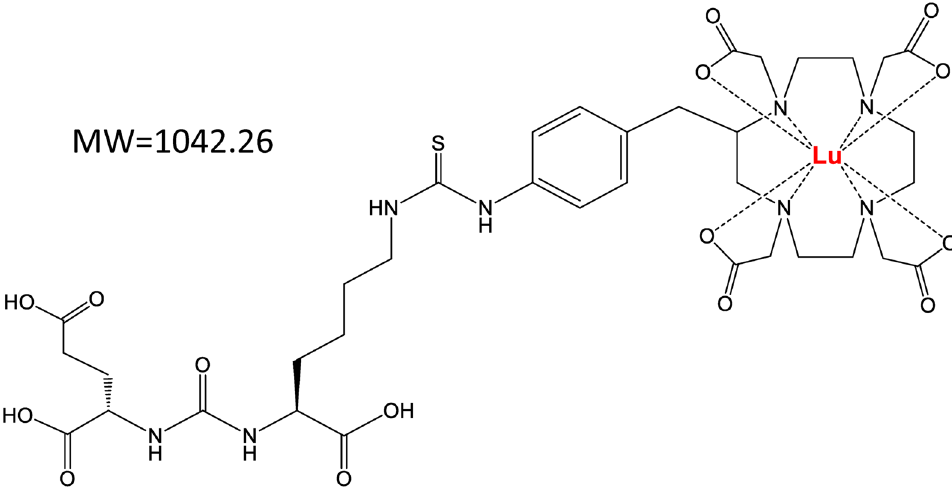
Figure 1. Structure of a Lu-labeled PSMA-targeted ligand, Lutetium labeled-1,4,7,10-tetraazacyclododecane- 1,4,7,10-tetraacetic acid